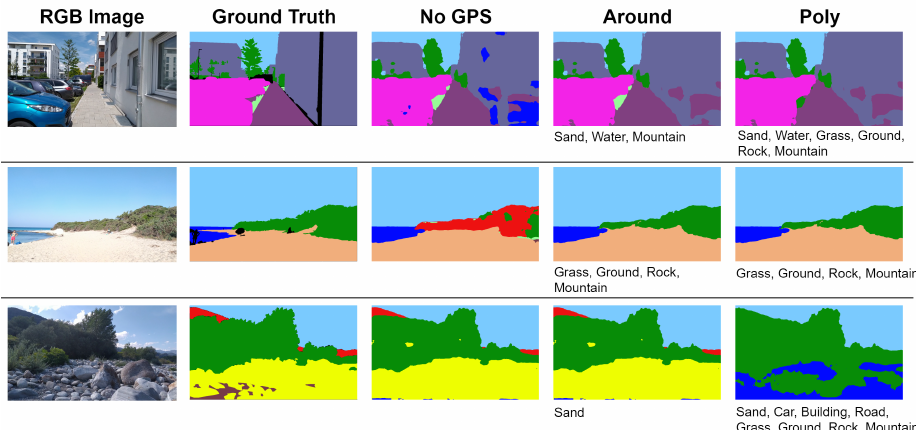
Figure 5. Predictions on the NP dataset to compare the raw Fast-SCNN outputs with the seg- mentations obtained integrating information from OSM. The removed classes are listed below the corresponding